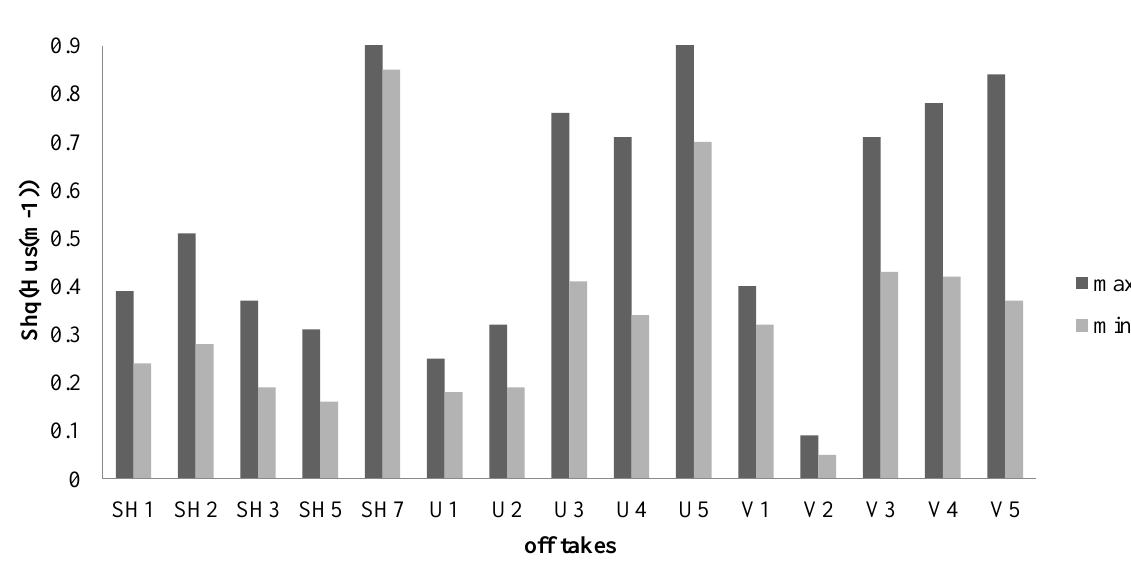
Fig. 6 Offtake sensitivity of delivery to absolute deviation of water depth Index (Calculated